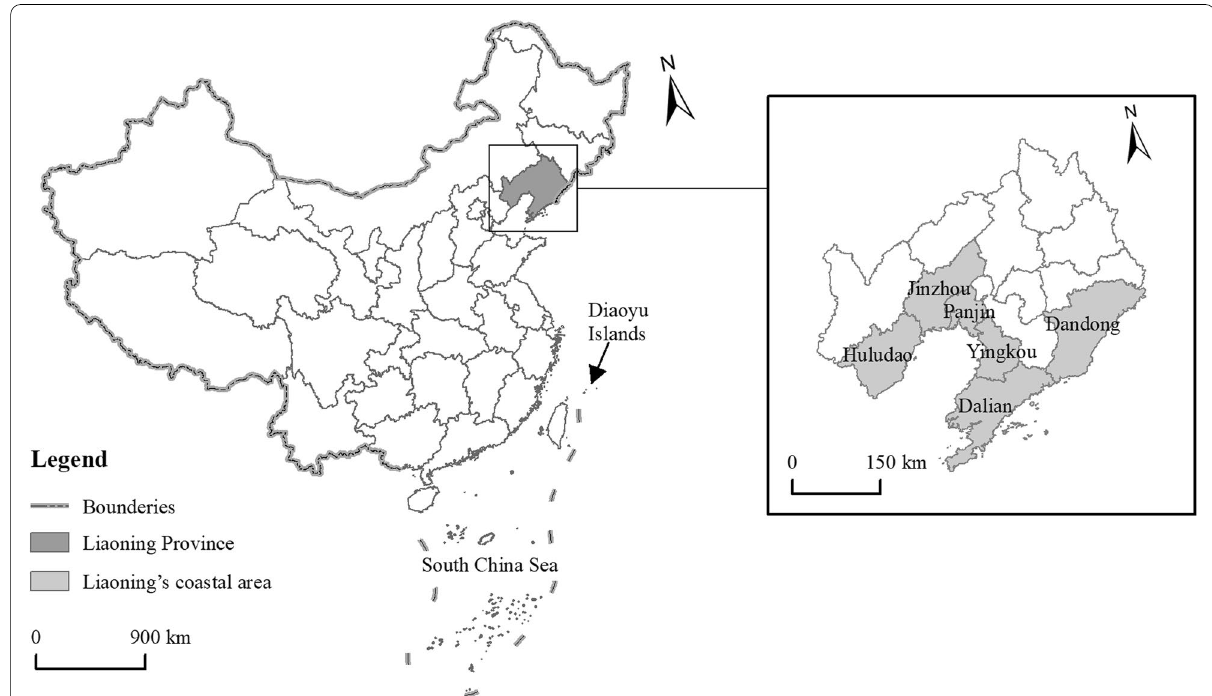
Fig. 1 Location of Liaoning Province,